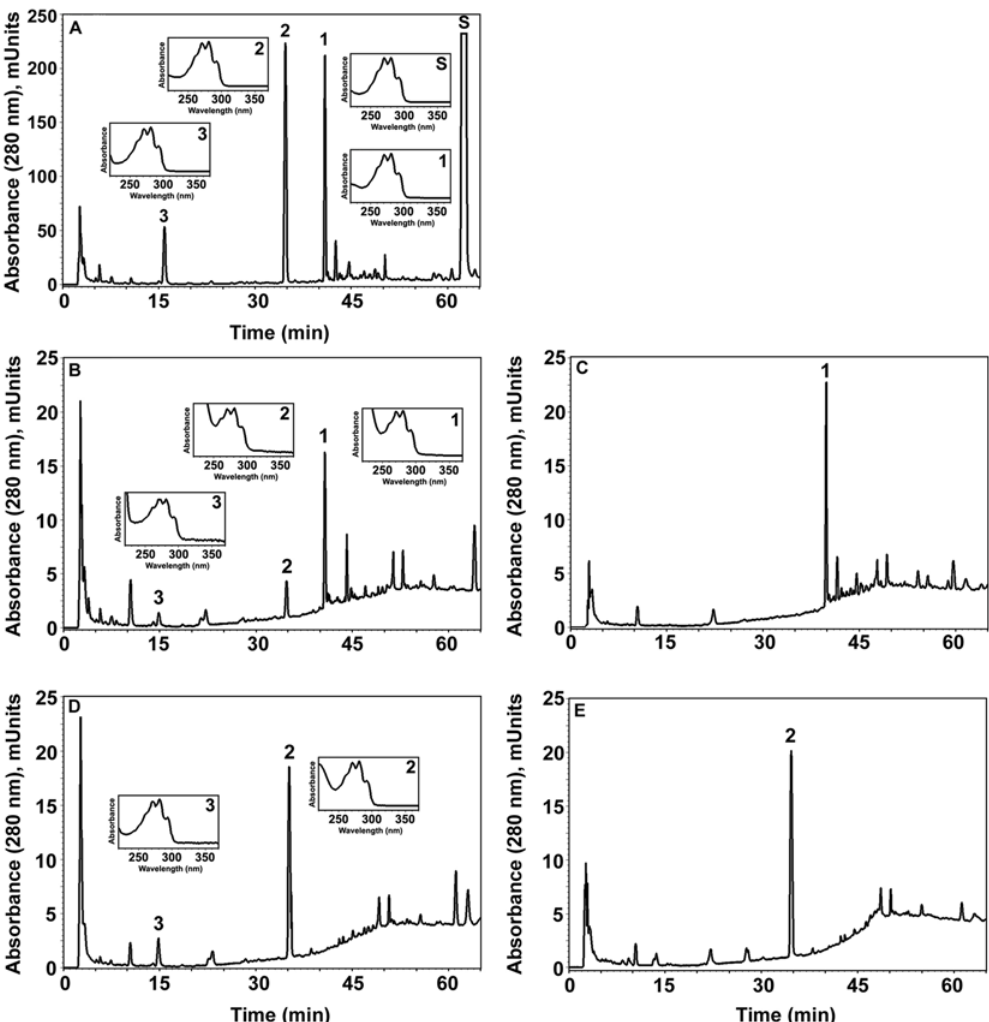
Figure 2. Precursor-product relationship between 7DHC, hydroxy-7DHC, dihydroxy-7DHC and 7DHP defined by their sequential metabolism by rat adrenal glands. A. Chromatogram showing metabolism of 7DHC(S) by adrenal glands. The hydroxy-7DHC (1) and dihydroxy- 7DHC (2) products were collected from the HPLC and tested as substrates (see B–E). Product 3 was identified as 7-DHP based on RT, mass and UV spectra. B. Incubation of hydroxy-7DHC (1) with adrenal glands generated dihydroxy-7DHC with RT 34.8 min (2) and 7DHP with RT 15.8 min (3). C. Boiled adrenal glands served as a control for B. D. Incubation of dihydroxy-7DHC (2) with adrenal glands produced 7DHP; note the lack of S and product 1. E. Negative control for D (boiled adrenal glands ). Inserts: UV spectra of compounds